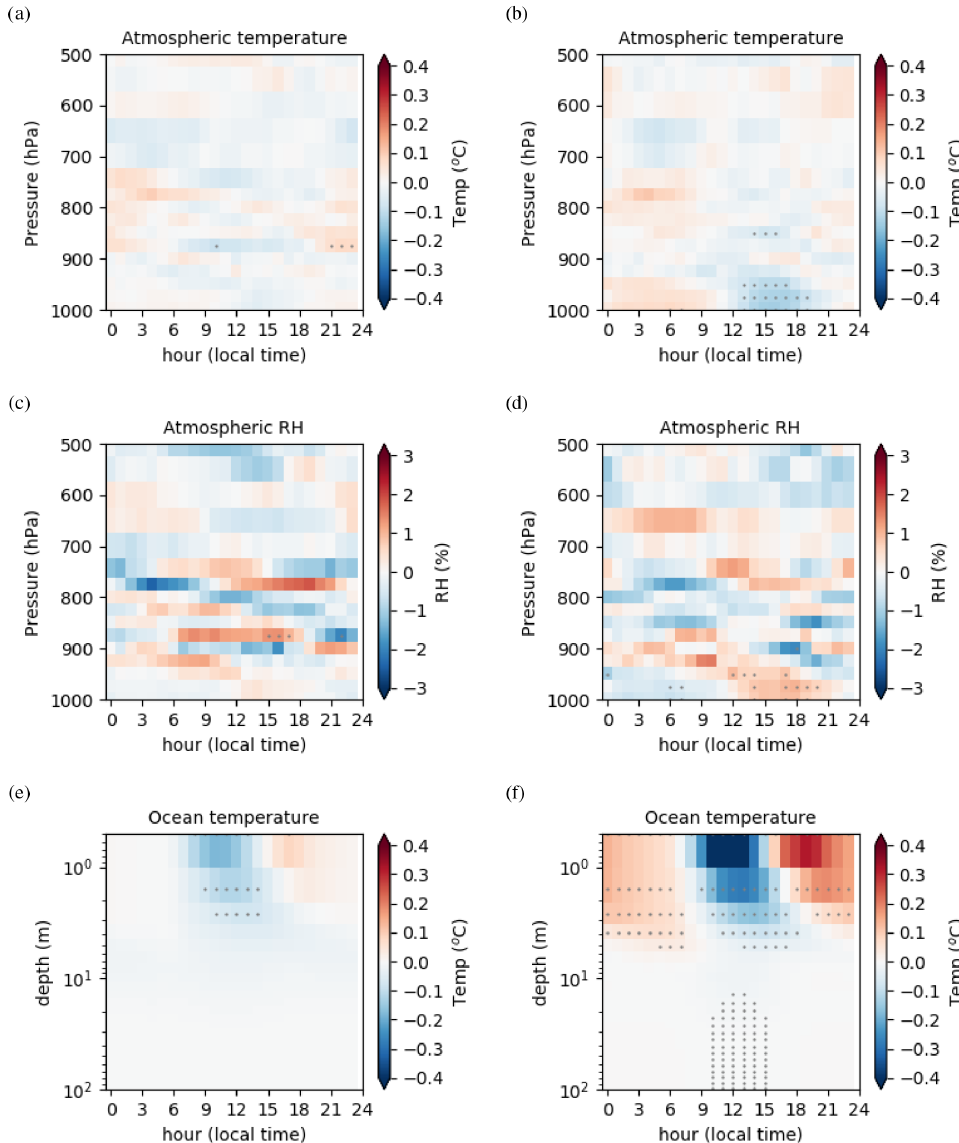
Figure 16. Change in mean daily cycle between the 1h coupling experiment and the 5min coupled experiment (left) and between the 3h coupling experiment and the 5min experiment (right) for (a, b) the atmospheric temperature ( ◦ C), (c, d) the relative humidity (%), and (e, f) the ocean temperature ( ◦ C). Dots indicate significant differences according to a Student’s t test at the 95% confidence